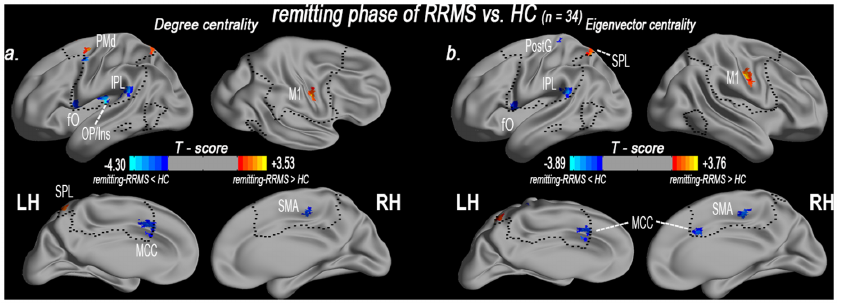
Fig 4. Altered centrality of the sensory-motor network in the remitting phase of RRMS patients. The spatial distribution of abnormal DC (a) and EC (b) in the remitting phase of RRMS patients ( P < 0.05, AlphaSim corrected critical cluster size k = 20) as visualized using surface brain imaging in Brainnet Viewer